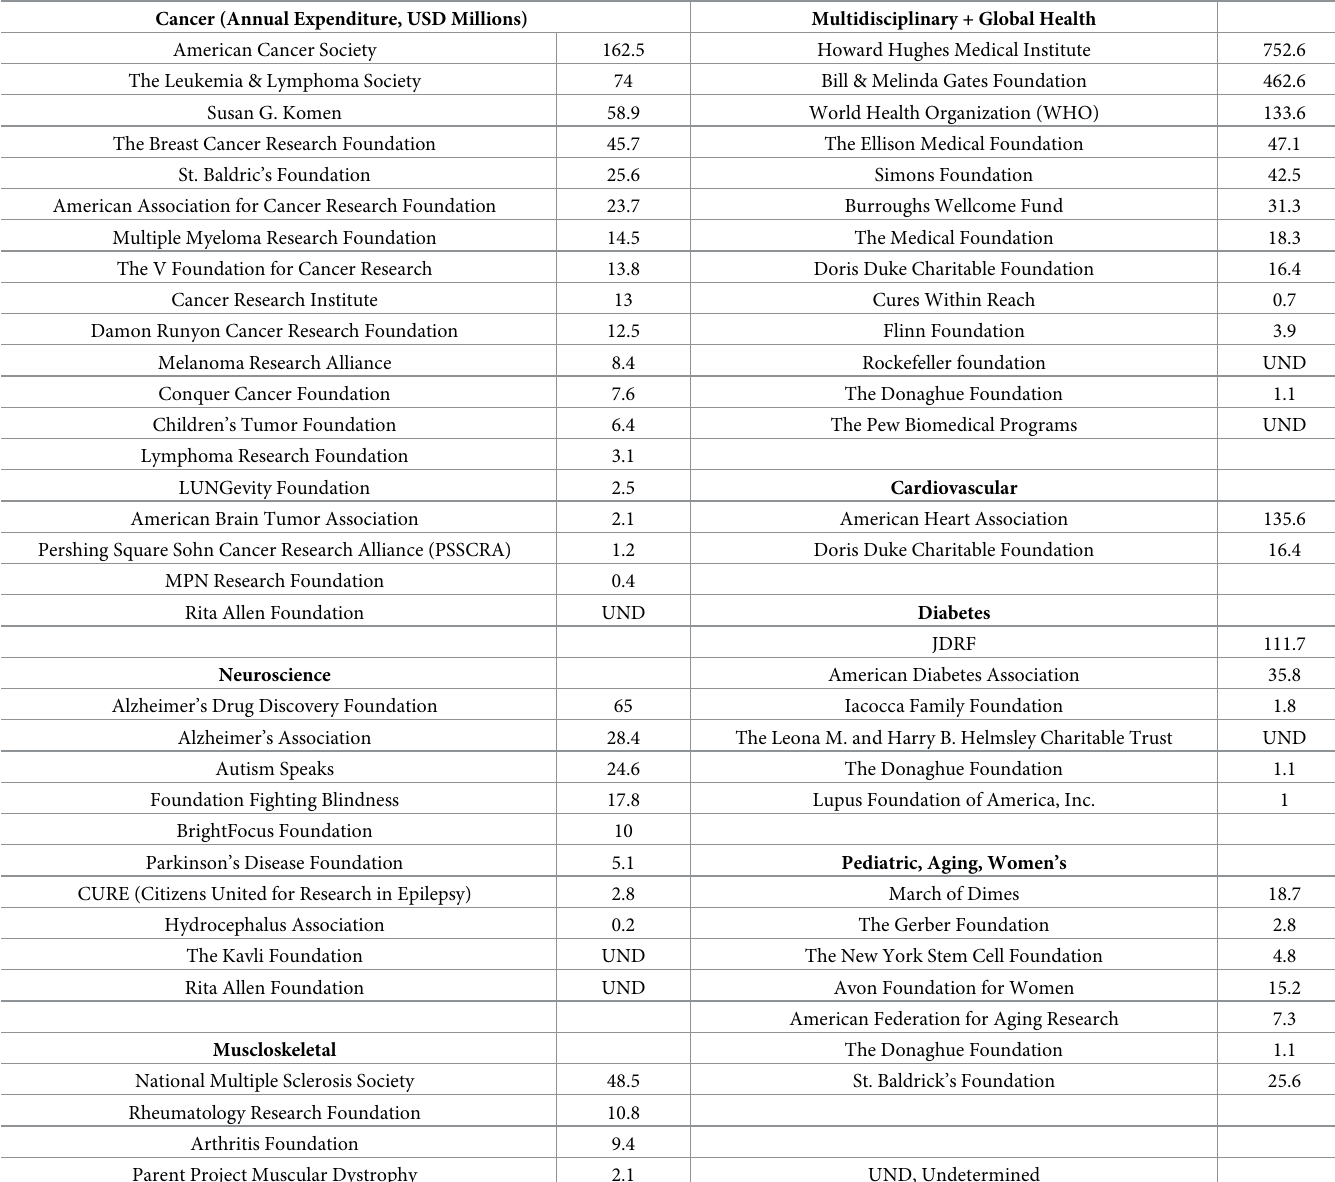
Table 1. Annual expenditure and biomedical research areas of interests for US-based philanthropic funding agencies. Table adapted from [45]. Cancer (Annual Expenditure, USD